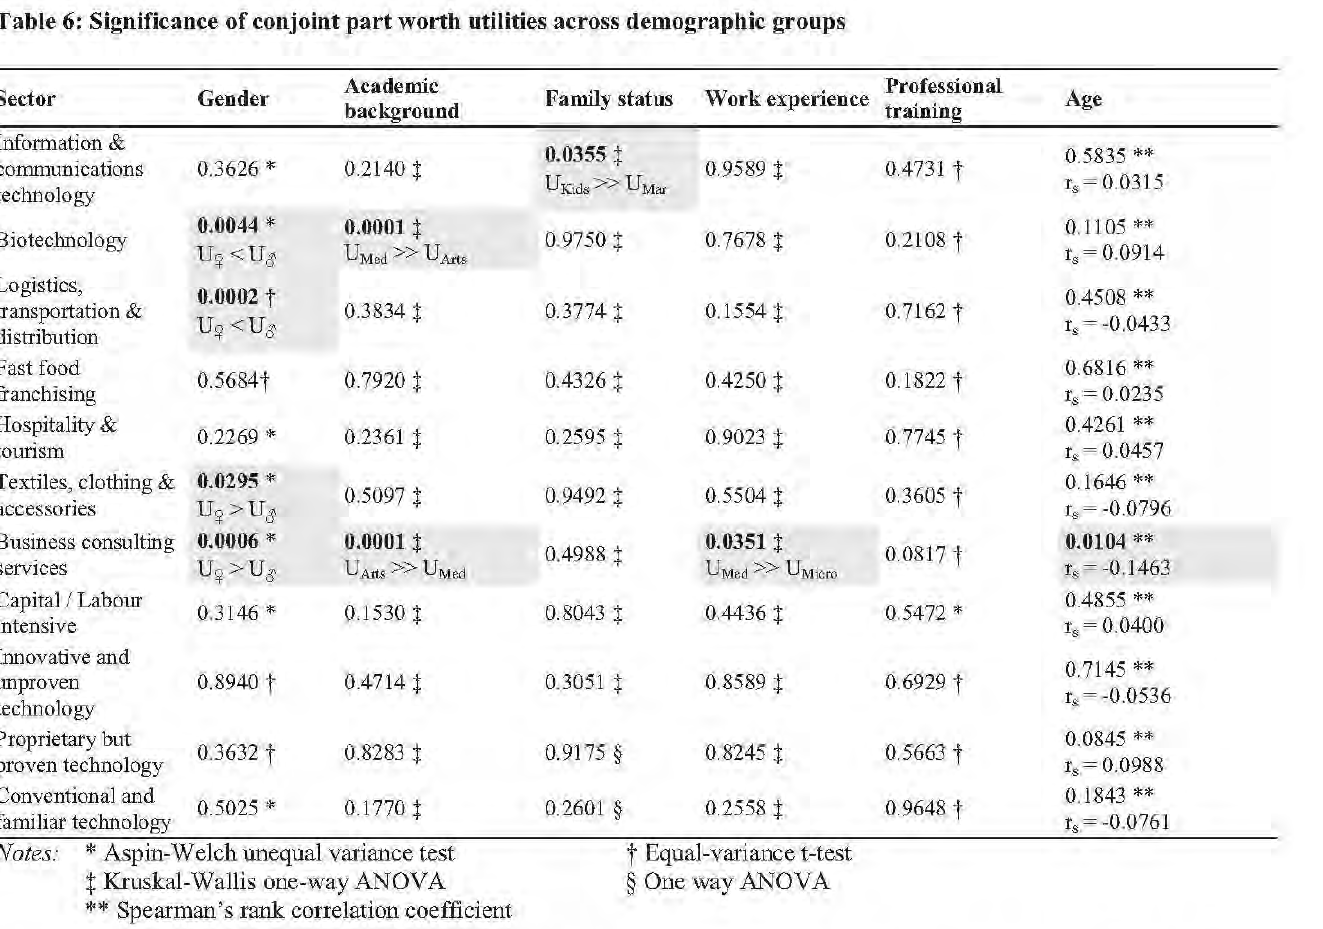
Table 6: Significance of conjoint part worth utilities across demographic